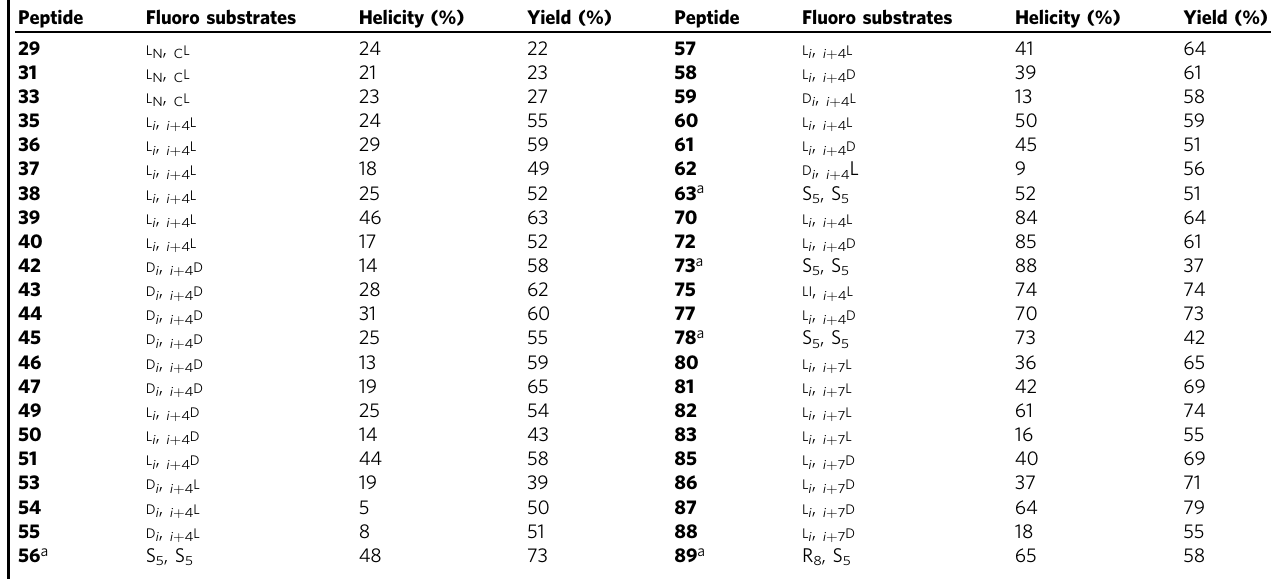
Bold indicates peptide numbering. a Control peptides stapled by ring-closing